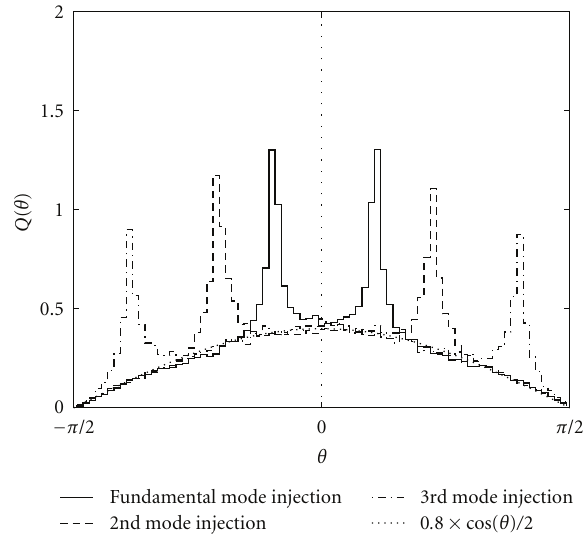
Figure 6: Angular distributions Q ( θ ) of the reflected electrons for the injection of each three propagating modes; Kd = 10, r max = 4, a max = 1 . 5.